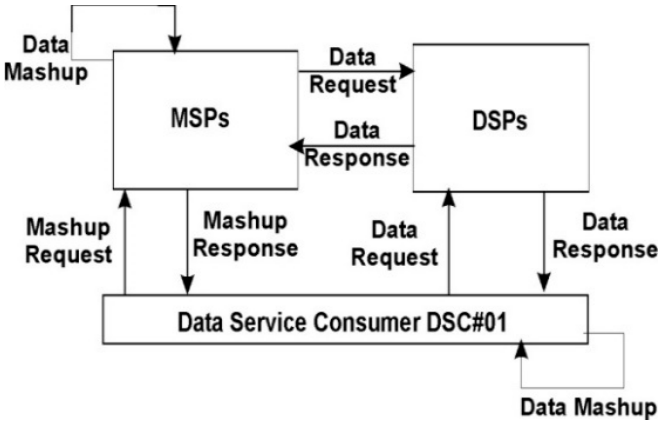
Figure 4. SDRest System Architecture for Any Time Access (ATA).